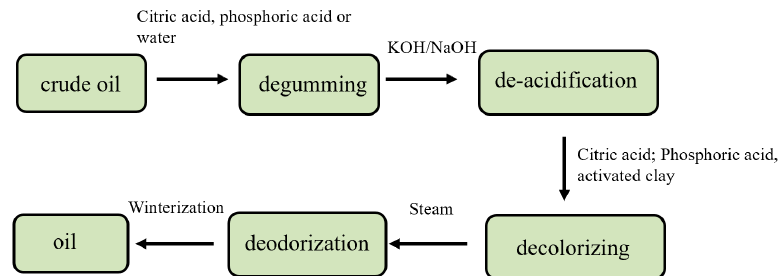
Figure 1. Flow chart of the camellia oil refining process.